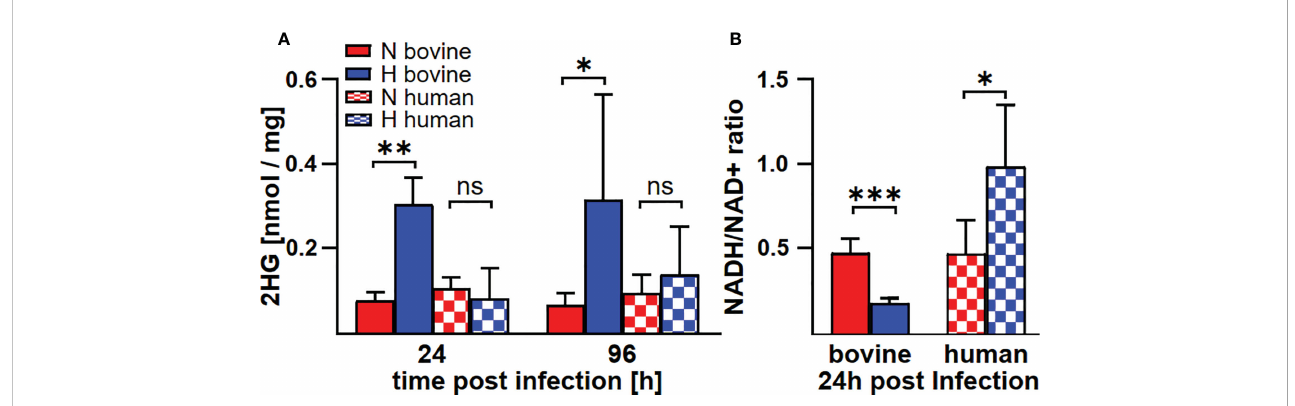
FIGURE 7 C. burnetii infection induces an increase of 2HG and a reduction of the NADH/NAD+ ratio only in hypoxic macrophages. Human and bovine macrophages were infected with C. burnetii NMII for the time periods indicated under normoxia (N) or hypoxia (H). (A) The amounts of 2HG (2- hydroxyglutarate) were analyzed by GC-MS and are shown in nmol/mg protein for three to four independent experiments. Unpaired t-test, n=3-4. **p<0.01, *p<0.05, ns=p>0.05. (B) NADH and NAD+ were analyzed in pmol using a colorimetric NAD+/NADH assay. The NADH/NAD+ ratio was calculated from 2-3 independent experiments performed in duplicate or triplicate. Mean ± SD, unpaired t-test. ***p<0.001, **p<0.01,